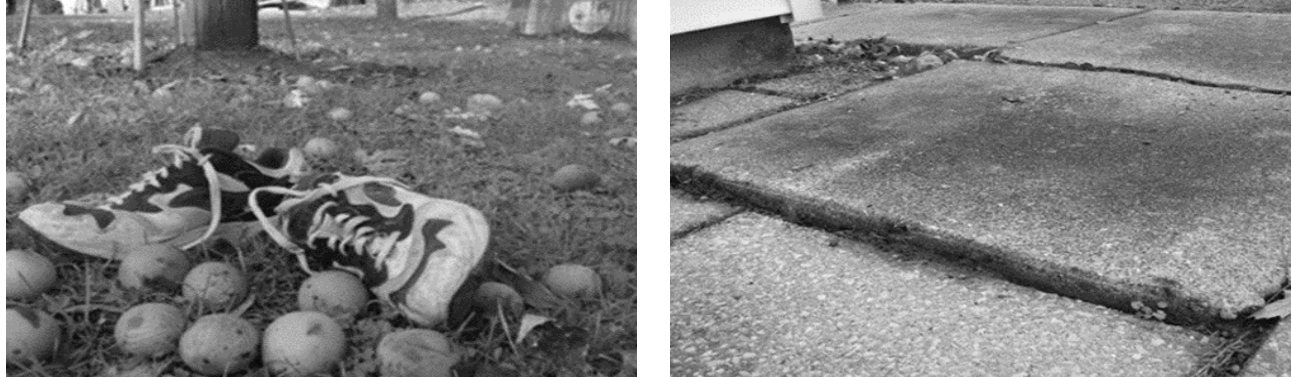
Figure 3. The more abstract photo on the left was staged recalling a time when stepping on a fallen walnut led to a twisted ankle. On the right is a more concrete photo, showing an uneven concrete surface as a trip hazard.